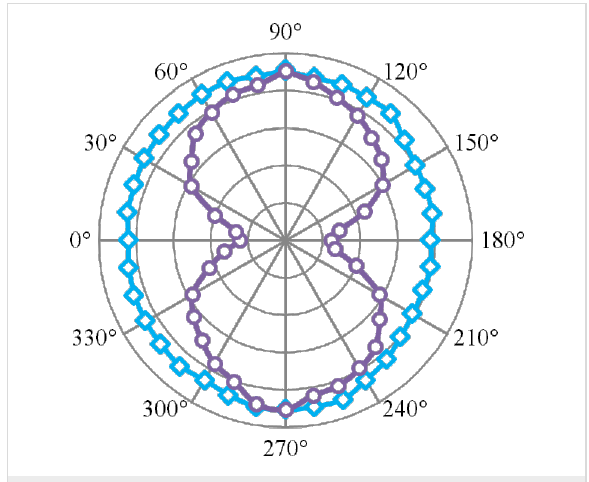
Figure 7: Polar plot for plasmon excited (circles) and b) bulk QDs (squares). The radial scale goes from 0 to 1.